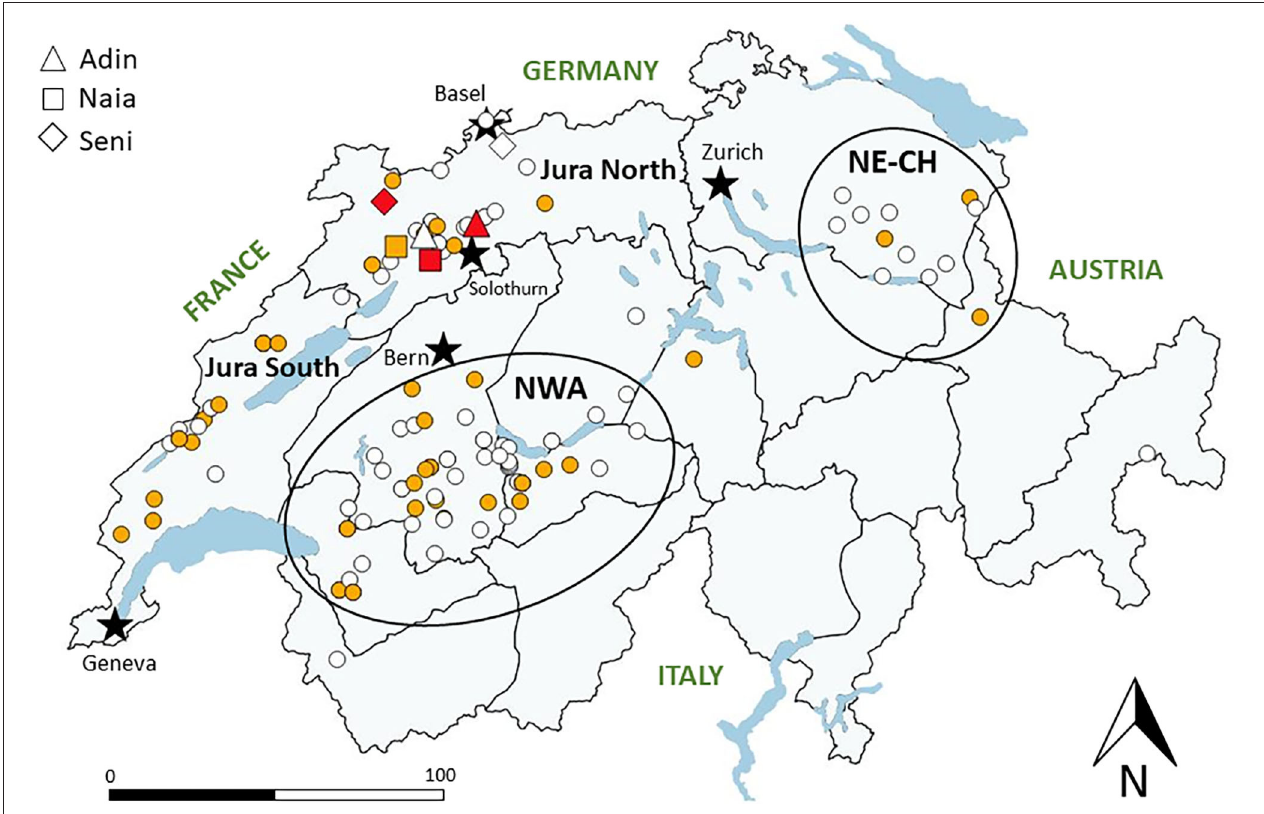
FIGURE 1 | Map of Switzerland with main lakes (blue areas) and five main cities (black stars) depicting the localization of lynx tested for FIV antibodies by Western blot from 2001 to 2021. White: FIV-seronegative (no band); yellow: FIV-negative but p24 band reaction (unspecific cross-reaction, early or late FIV infection phase); red: FIV-seropositive (both p24 and p15 bands). ADIN, NAIA, and SENI are indicated twice (before and after seroconversion), while all other tested lynx (dots) appear only once (first test). Gray lines indicate borders of current lynx management compartments, and black circles indicate the relevant Alpine subpopulation (north-western Alps, NWA) and the more recent small population in north-eastern Switzerland (NE-CH). Jura North and Jura South refer to the lynx management compartment corresponding to the Swiss part of the Jura lynx